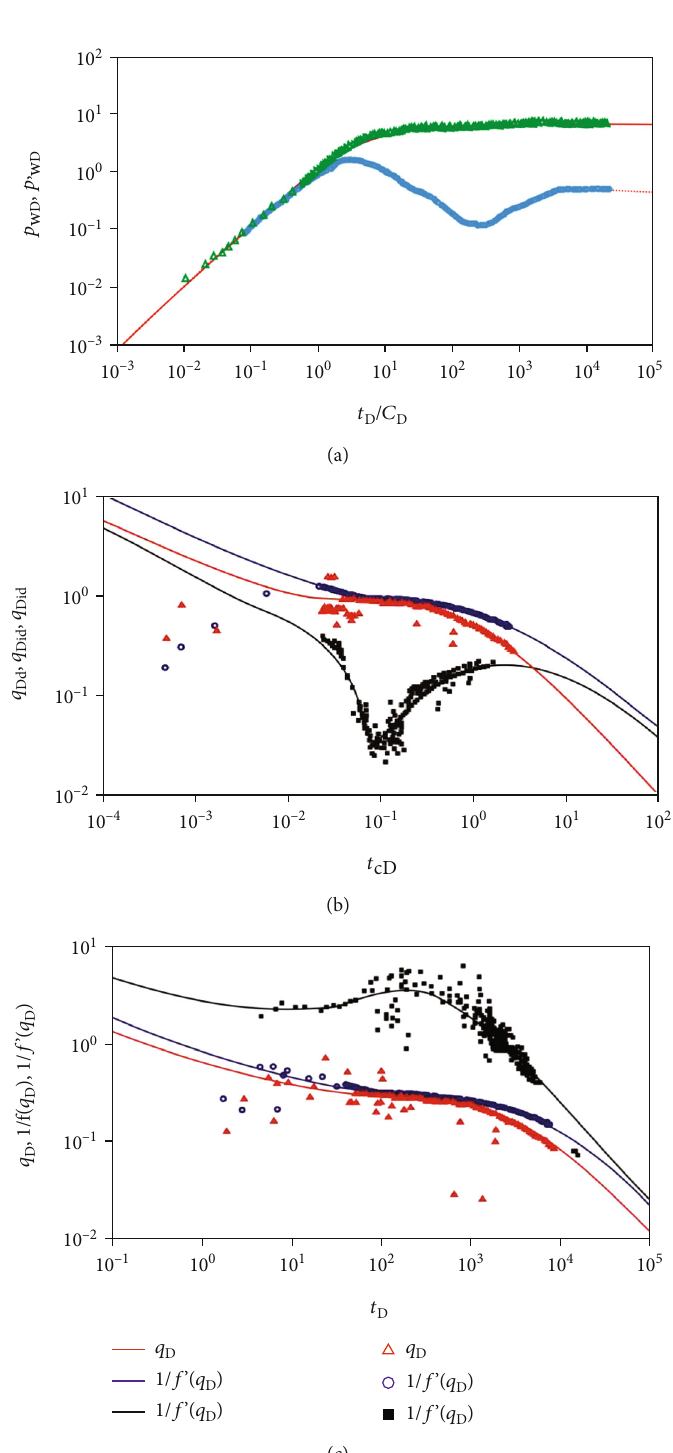
Figure 15: Matching curves for fi eld case 1: (a) well test analysis; (b) Blasingame type analysis; (c) new type curve